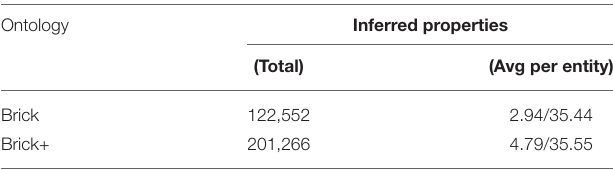
TABLE 6 | Number of inferred properties for all entities across 104 Brick models in Brick and Brick+.